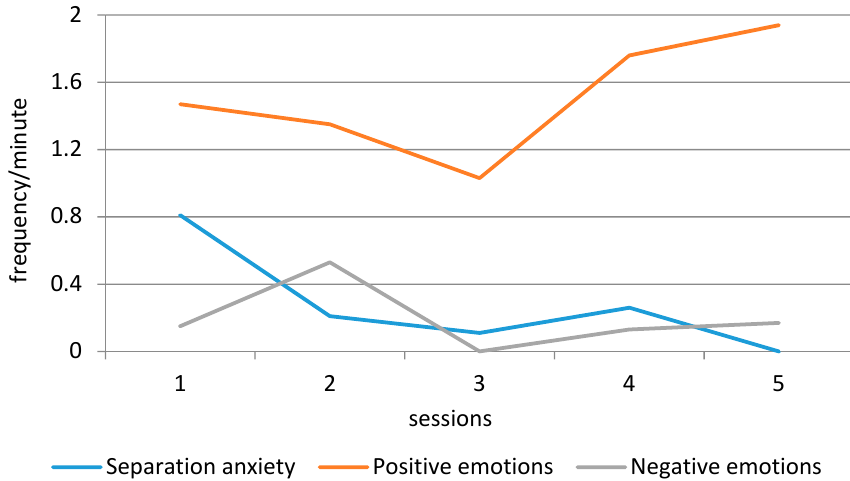
Figure 2. Graphical display of the participant’s turn-taking skills over time.